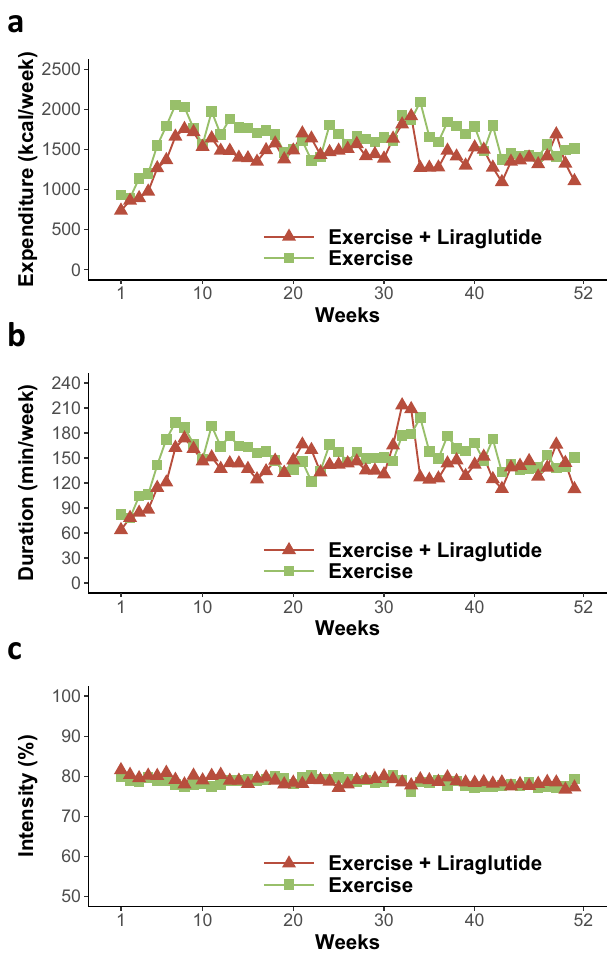
Fig. 3 | Performed exercise during the study. a Weekly energy expended during exercise(kcal/week), b weeklyexerciseduration(min/week),and c weeklyexercise intensity (percentage of maximum heart rate) from the fi rst week after randomi- zation(week1)throughouttheone-yearinterventionperiodinthetwogroupsthat included an exercise intervention: exercise (green color, n =26) and the combina- tion of exercise and liraglutide (red color, n =29). The exercise program consisted of a gradual increase from week 1 to 6 after which the exercise program was fully implemented. Plotted values are observed means for study participants who adhered to the study interventions (per protocol population). Source data are provided as a Source Data fi